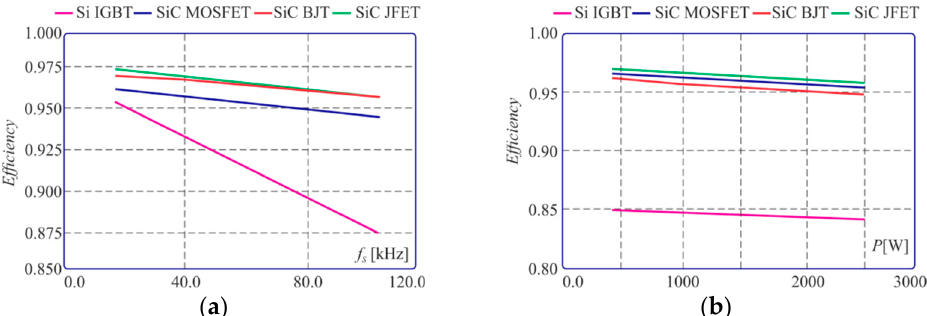
Figure 9. Main topologies for SiC bi-directional switches: ( a ) common drain anti-paralleled JFET, ( b ) common source anti-paralleled SiC MOSFET, and ( c ) common emitter anti-paralleled SiC BJT.